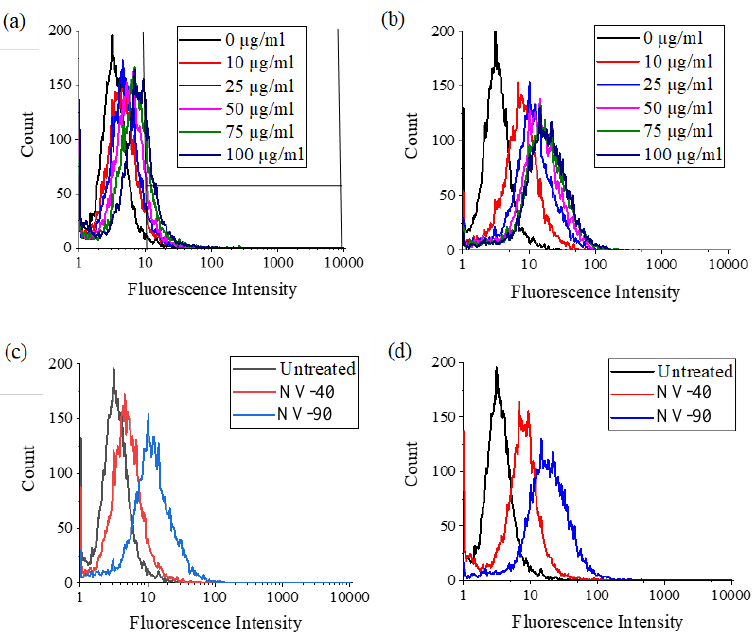
Figure 6. Live cell flow cytometry of MSCs in PBS labelled with various concentrations of ( a ) NV-40 and ( b ) NV-90 NDs for 24 h. The fluorescence intensity of MSCs labelled with both NV NDs at concentrations of ( c ) 25 µ g/ml and ( d ) 100 µ g/mL is also shown. Fluorescence intensity was measured using the FL3 filter (670 LP), where 10,000 events were counted, and the fluorescence gating used for all experiments was the same as in ( a ).